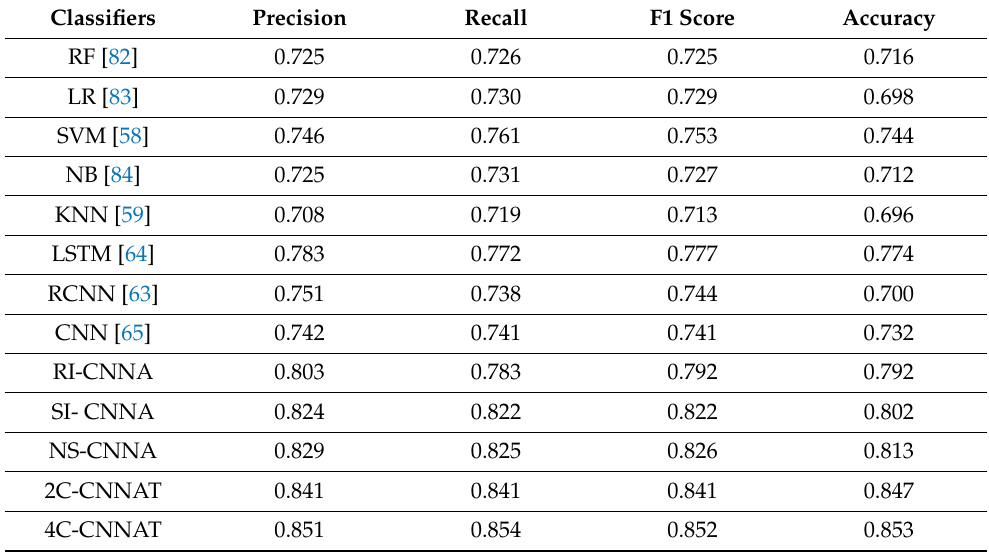
Table 3. 4C-CNNAT performance comparison with various ML/DL classifiers using RUSA-19 corpus.